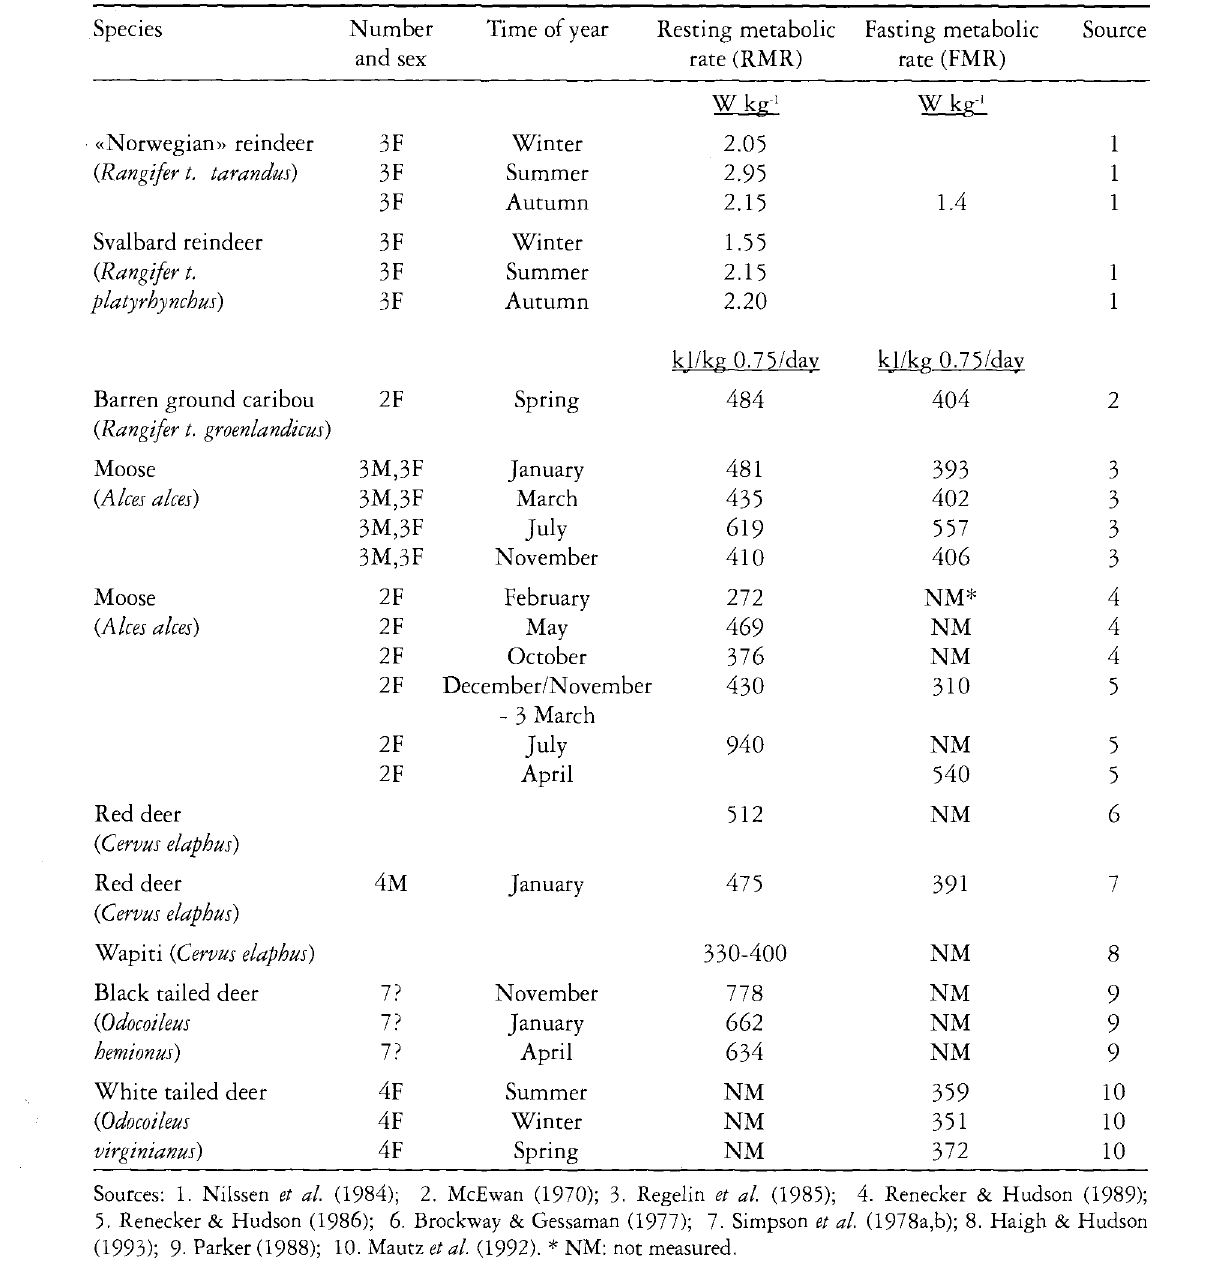
Table 7. Comparison of metabolic rates in Cervidae. Species Number Time of year Resting metabolic Fasting